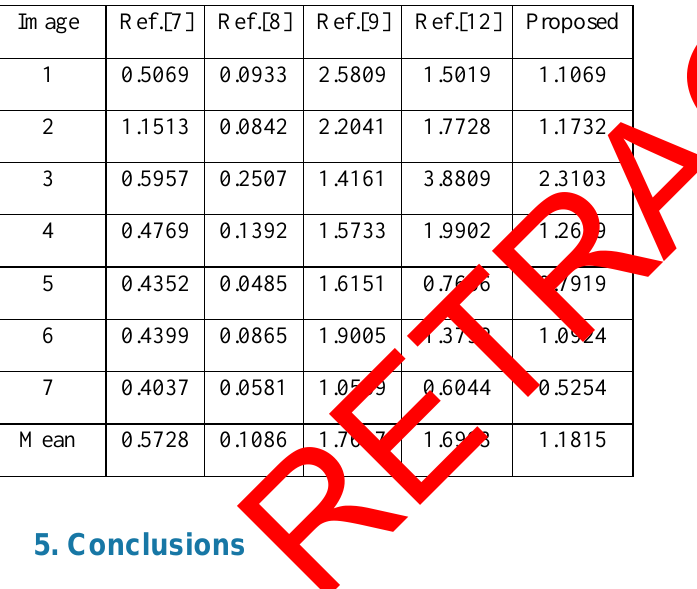
Table 4. running time values with different